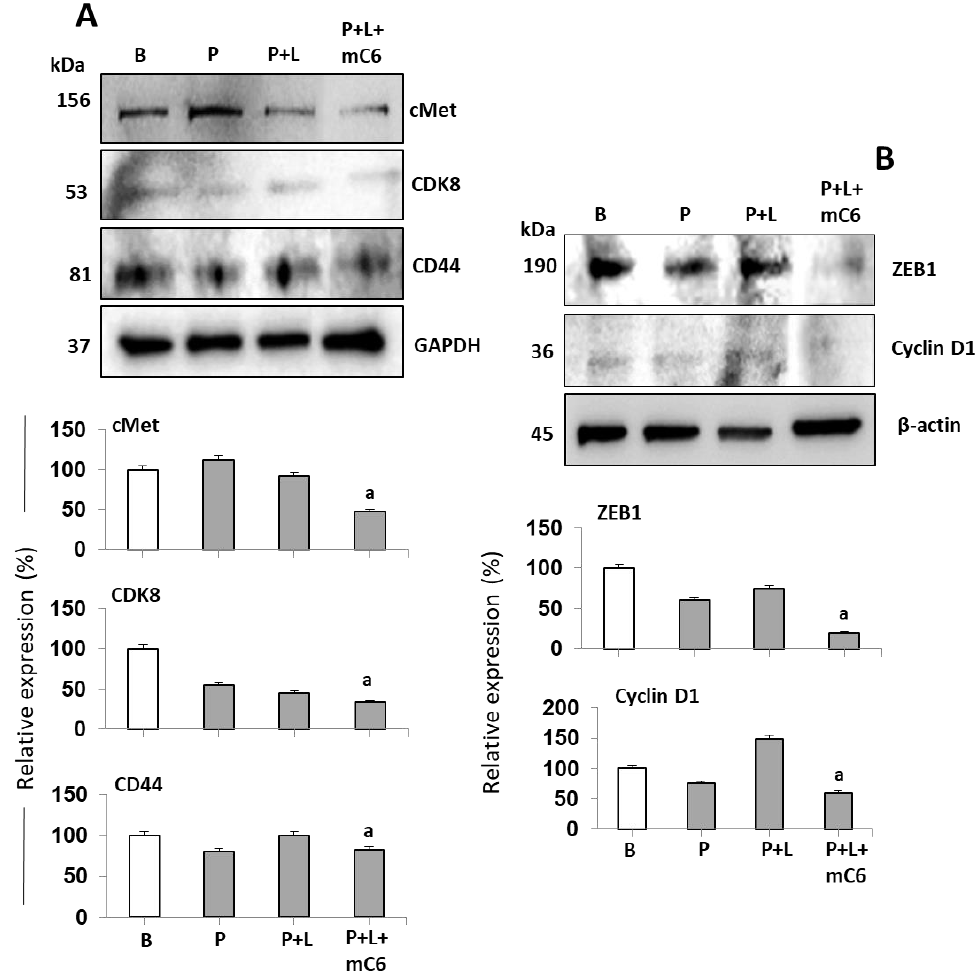
Figure 7. Inhibition of leptin signaling reduces the expression of key tumorigenic proteins in paclitaxel-treated triple-negative breast cancer cells. ( A ) Leptin antagonism e ff ects on levels of cMet, CK8 and CD44 and ( B ) Cyclin D1 and ZEB1 in MDA-MB231 cells treated with paclitaxel. Cells were treated with paclitaxel (P, 0.5 mM); P + leptin (L, 6.25 nM) and P + L + mC6 leptin antagonist (12.5 nM) for 72 h. Western blot assays were used to determine protein levels. “B”: basal (no treatment). “a”: p ≤ 0.05 compared to P + L.